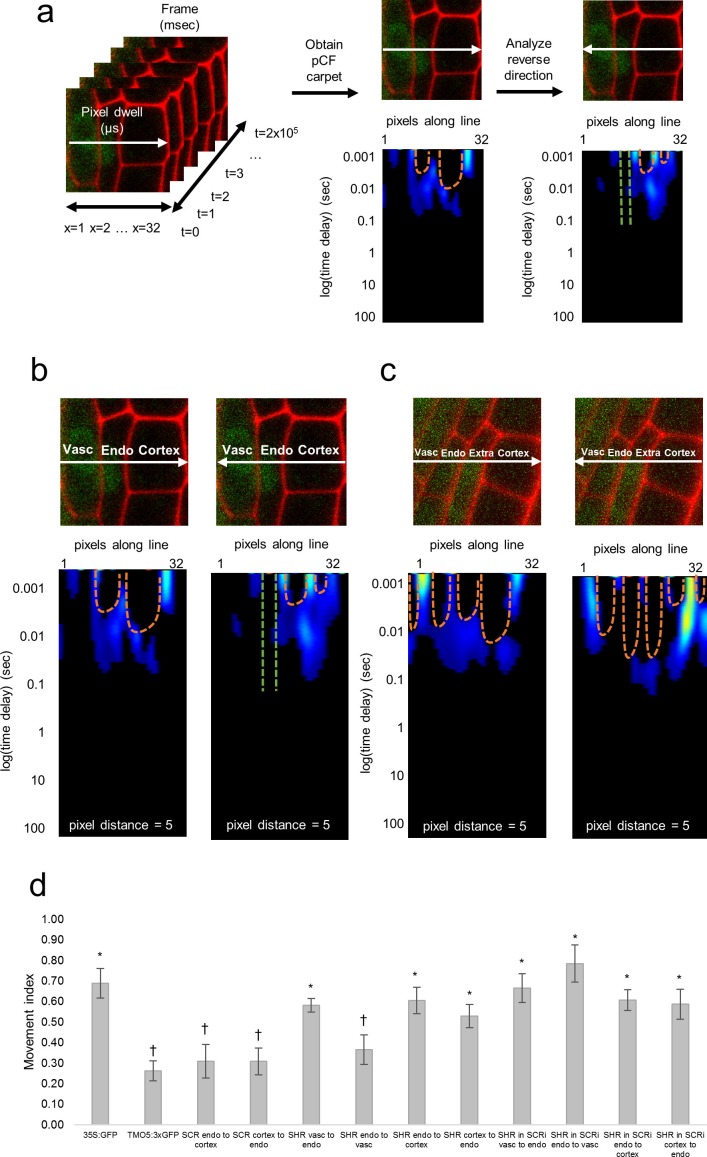
Pair correlation function (pCF) analysis showing direction of SHR movement.(a) Schematic of image acquisition and pCF analysis. (Left) Line scans acquired using predetermined imaging conditions (Table 1). Carpets of the forward (middle) and reverse (right) pCF analysis. The orange arch indicates delayed movement, while the absence of an arch (green lines) indicates no movement. (b) pCF analysis of SHR:SHR-GFP in shr2. Cell walls are marked with PI. Lines indicate the laser path going across the vasculature, endodermis, and cortex. pCF carpets for each direction are shown. Orange arches indicate movement. (c) pCF analysis of SHR:SHR-GFP in SCRi. Cell walls are marked with PI. Lines indicate the laser path across the vasculature, endodermis, the extra layer, and the cortex. pCF carpets for each direction are shown. Orange arches indicate movement. (d) Bar graph showing average movement index of 35S:GFP (n = 15), TMO5:3xGFP (n = 19), SCR:SCR-GFP (n = 14), SHR:SHR-GFP in shr2 (n = 20) between vasculature and endodermis, n = 22 between endodermis and cortex), and SHR:SHR-GFP in SCRi (n = 14 between vasculature and endodermis, n = 17 between endodermis and cortex). Stars denote groups that are different from TMO5:3xGFP, crosses indicate groups that are different from 35S:GFP (Wilcoxon with Steel-Dwass, p<0.05). Error bars are s.e.m. Source data is provided in Figure 2—source data 1 and 2.DOI:
http://dx.doi.org/10.7554/eLife.14770.01010.7554/eLife.14770.011Figure 2—source data 1.pCF of 35S:GFP, TMO5:3xGFP, SCR:SCR-GFP, SHR:SHR-GFP in shr2, and SHR:SHR-GFP in SCRi lines.DOI:
http://dx.doi.org/10.7554/eLife.14770.01110.7554/eLife.14770.012Figure 2—source data 2.Statistical analysis of movement index obtained by pCF.